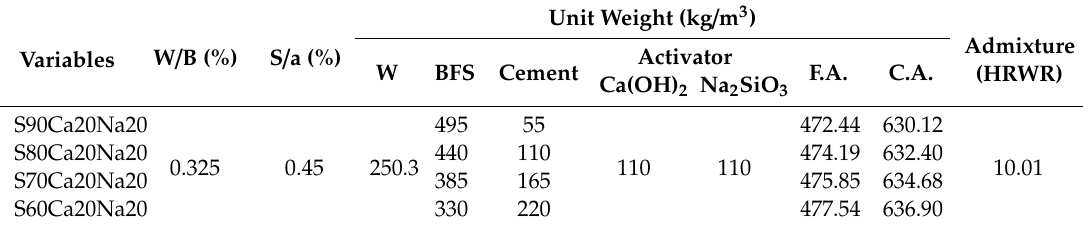
Table 6. Mix variables of carbon-capturing